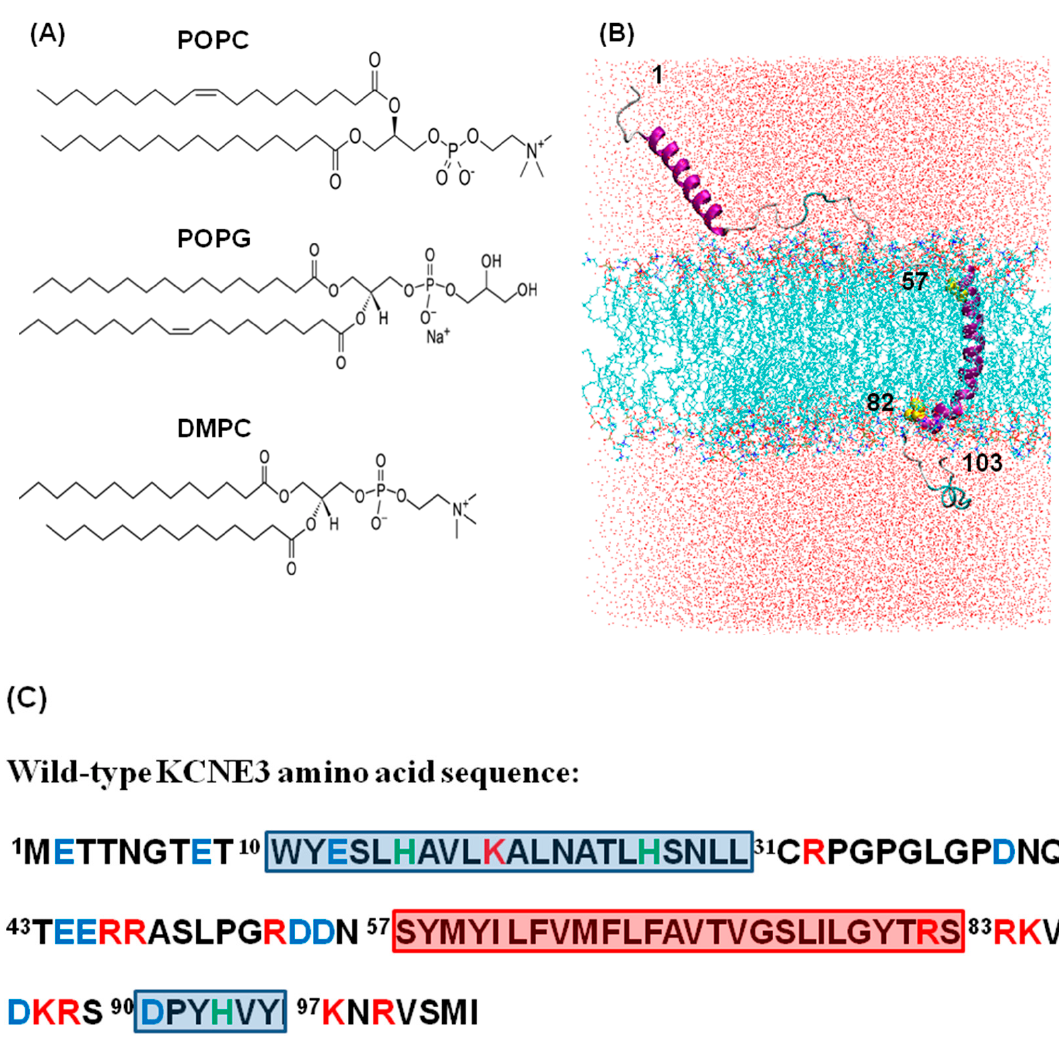
Figure 1. ( A ) Chemical structure of phospholipids used in the NAMD molecular dynamics simulations. ( B ) An illustrative example of the cartoon representation of the NMR structure of KCNE3 (PDB ID: 2M9Z) incorporated into POPC/POPG lipid bilayers and solvated into water box [16]. Amino acid sites 1–56 represent N-terminus, amino acid sites 57–82 represent TMD and sites 83–103 represent C-terminus. The amino acid sites 57 and 82 are colored yellow. ( C ) Amino acid sequence of the wild-type KCNE3 with distribution of charges. Positive charges (Red), negative charges (Blue), and Histidine (Green) are color coded. The highlighted red box represents the transmembrane domain and blue boxes represent N- and C-terminal helices.